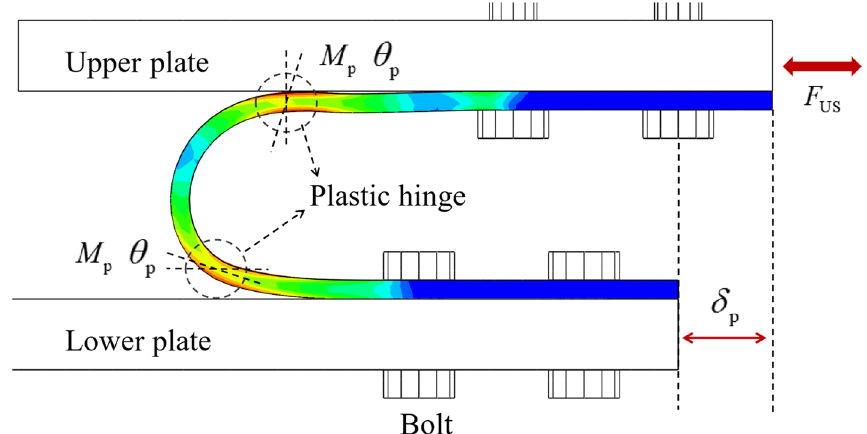
Fig. 5 Illustration for working principle of